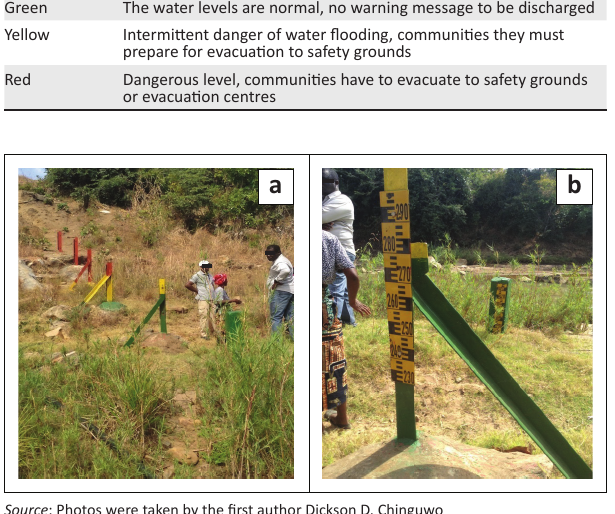
FIGURE 1: (a) Cross section of river gauges, (b) river gauge with readings. Location, Zomba District.